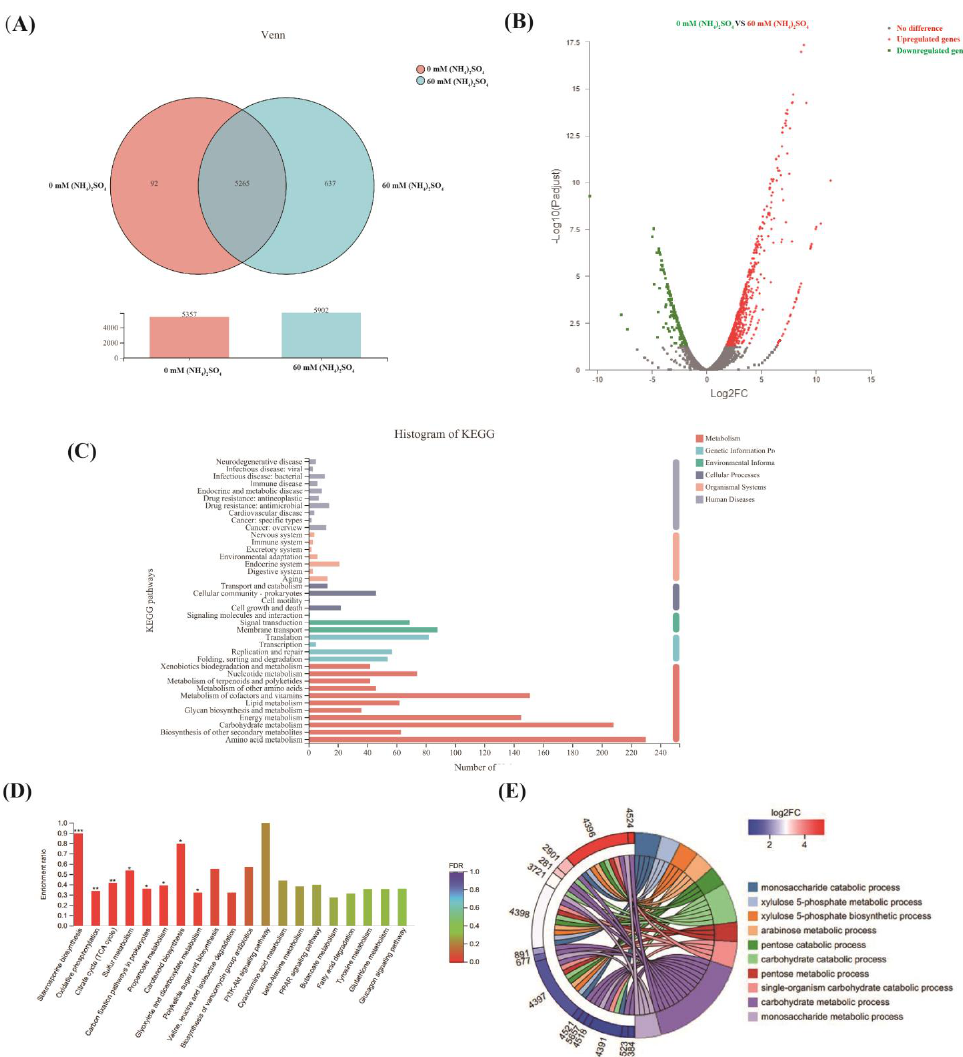
Figure 3. Comparative transcriptomic analysis of the effects of 60 mM (NH 4 ) 2 SO 4 on neomycin B biosynthesis: ( A ) Venn diagram analysis of differentially expressed genes. ( B ) Volcano plot analysis of differentially expressed genes. The x -axis represents the log 2 -transformed expression fold-change values. The y -axis represents the log 10 -transformed adjusted p -values. Red dots indicate upregulated genes and blue dots indicate downregulated genes. ( C ) KEGG enrichment analysis of the metabolic pathways in which differentially expressed genes are involved. The y -axis is the name of the KEGG metabolic pathway, and the abscissa is the number of genes annotated to the pathway. KEGG metabolic pathways can be divided into seven major categories: metabolism, genetic information processing, environmental information processing, cellular processes, organismal systems, human diseases, and drug development. ( D ) KEGG enrichment analysis of differentially expressed